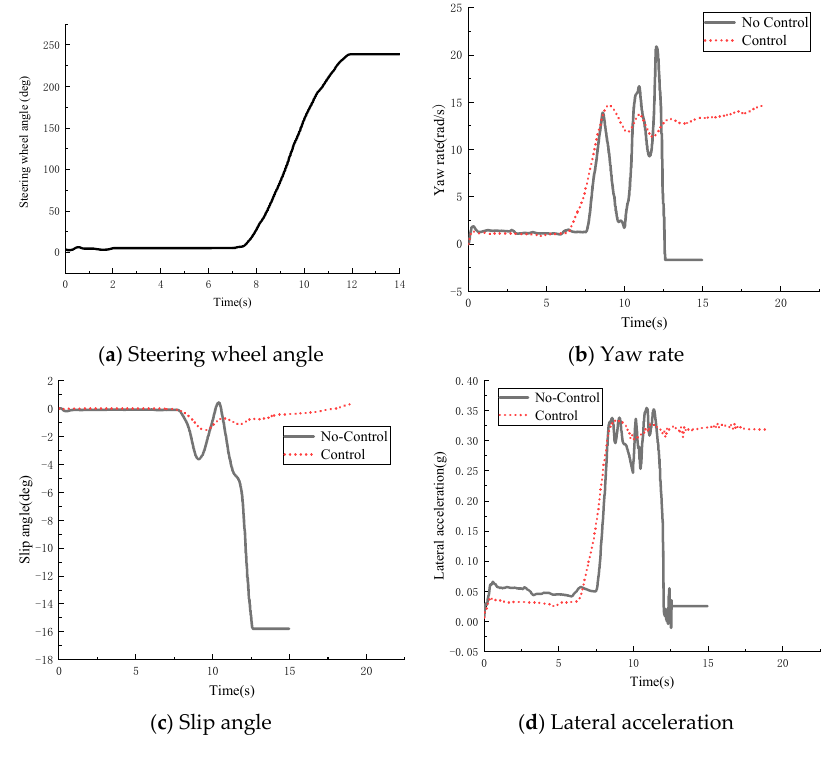
Figure 11. J-turn.